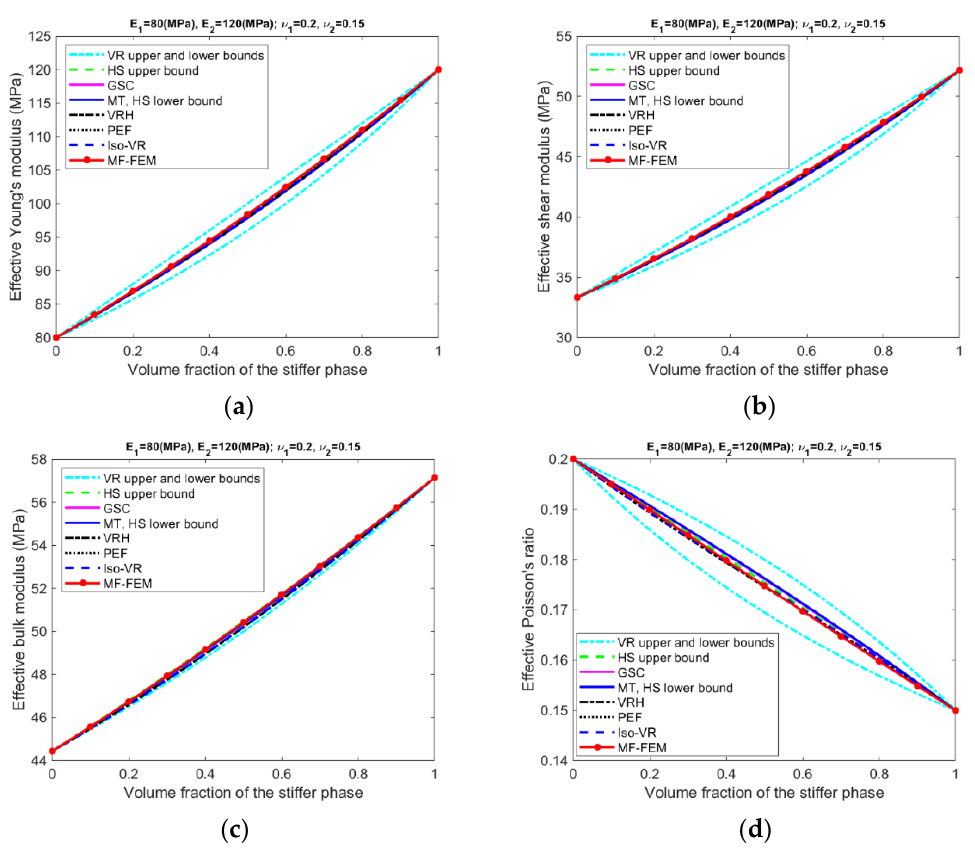
Figure A1. Composite #1—small contrast in both phase Young’s modulus and phase Poisson’s ratio. ( a ) Young’s modulus; ( b ) shear modulus; ( c ) bulk modulus; ( d ) Poisson’s